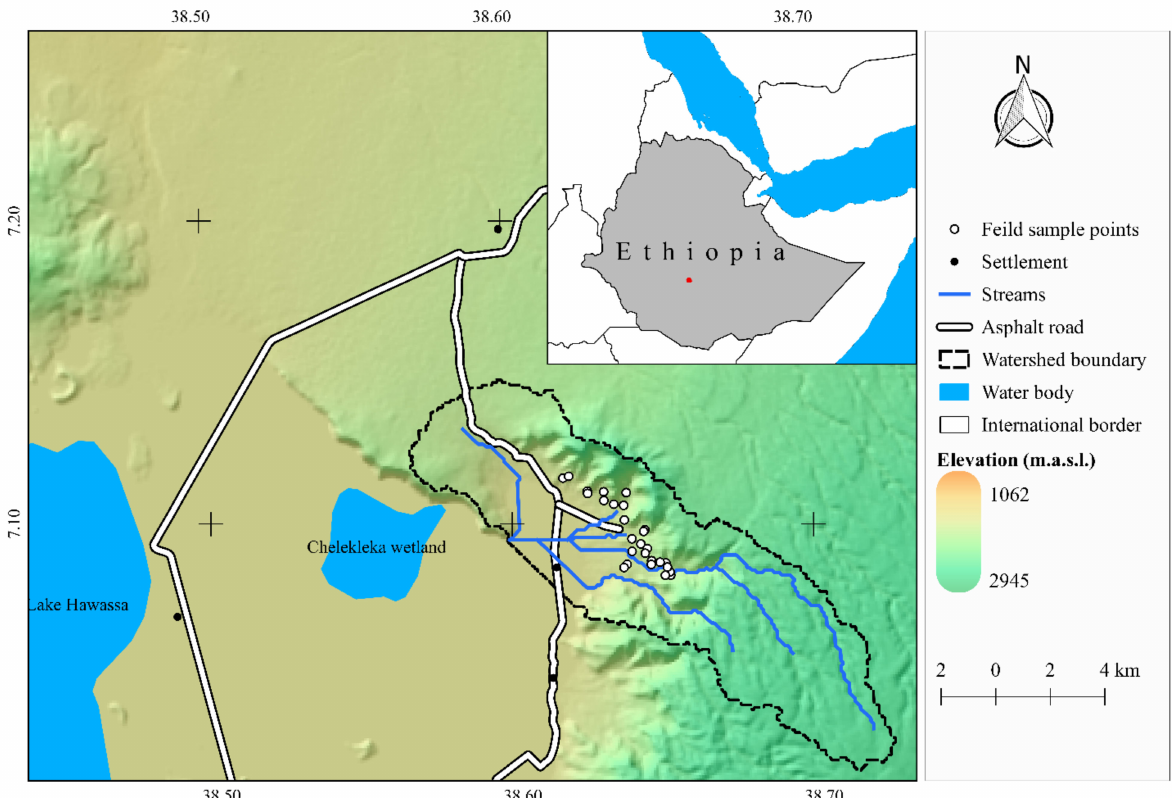
Figure 1. Location of the study area and distribution of the field